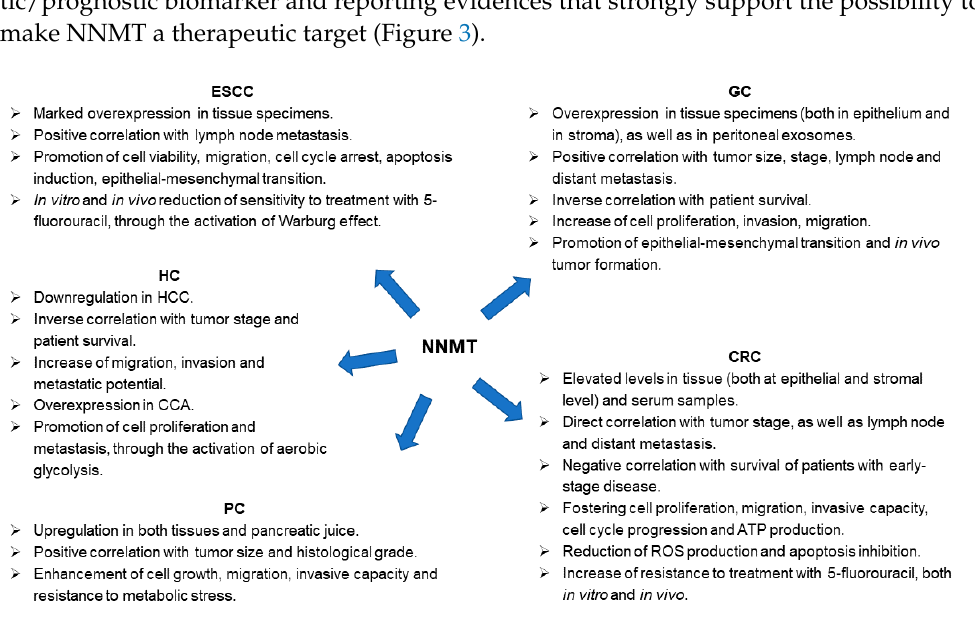
Figure 3. Nicotinamide N -methyltransferase (NNMT) role in gastrointestinal (GI) tumors. Panel illustrating differential expression (tumor versus control tissue) and enzyme involvement in cell phenotype and molecular processes featuring neoplasms affecting GI tract (ESCC, esophageal squamous cell carcinoma; GC, gastric cancer; CRC, colorectal cancer; HC, hepatic cancer; HCC, hepatocellular carcinoma; CCA, cholangiocarcinoma; PC, pancreatic cancer).